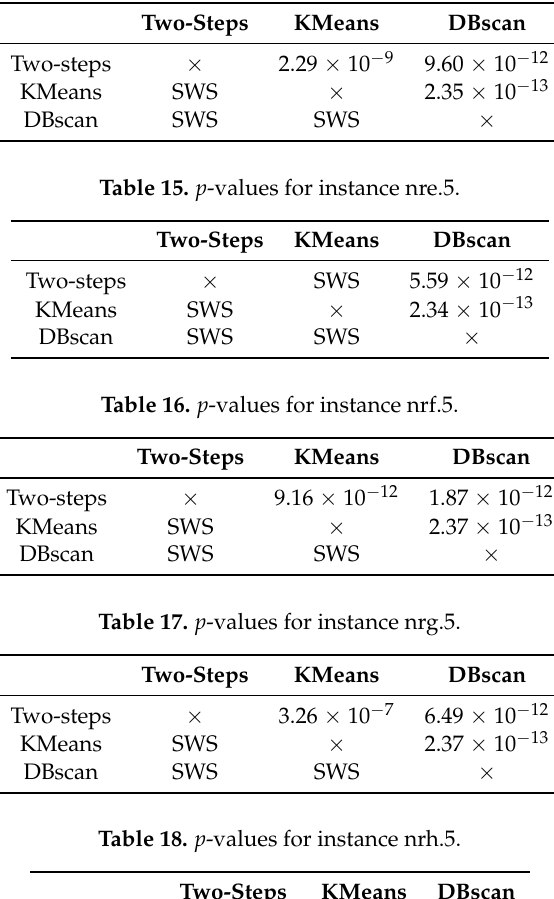
Table 14. p -values for instance d.5.